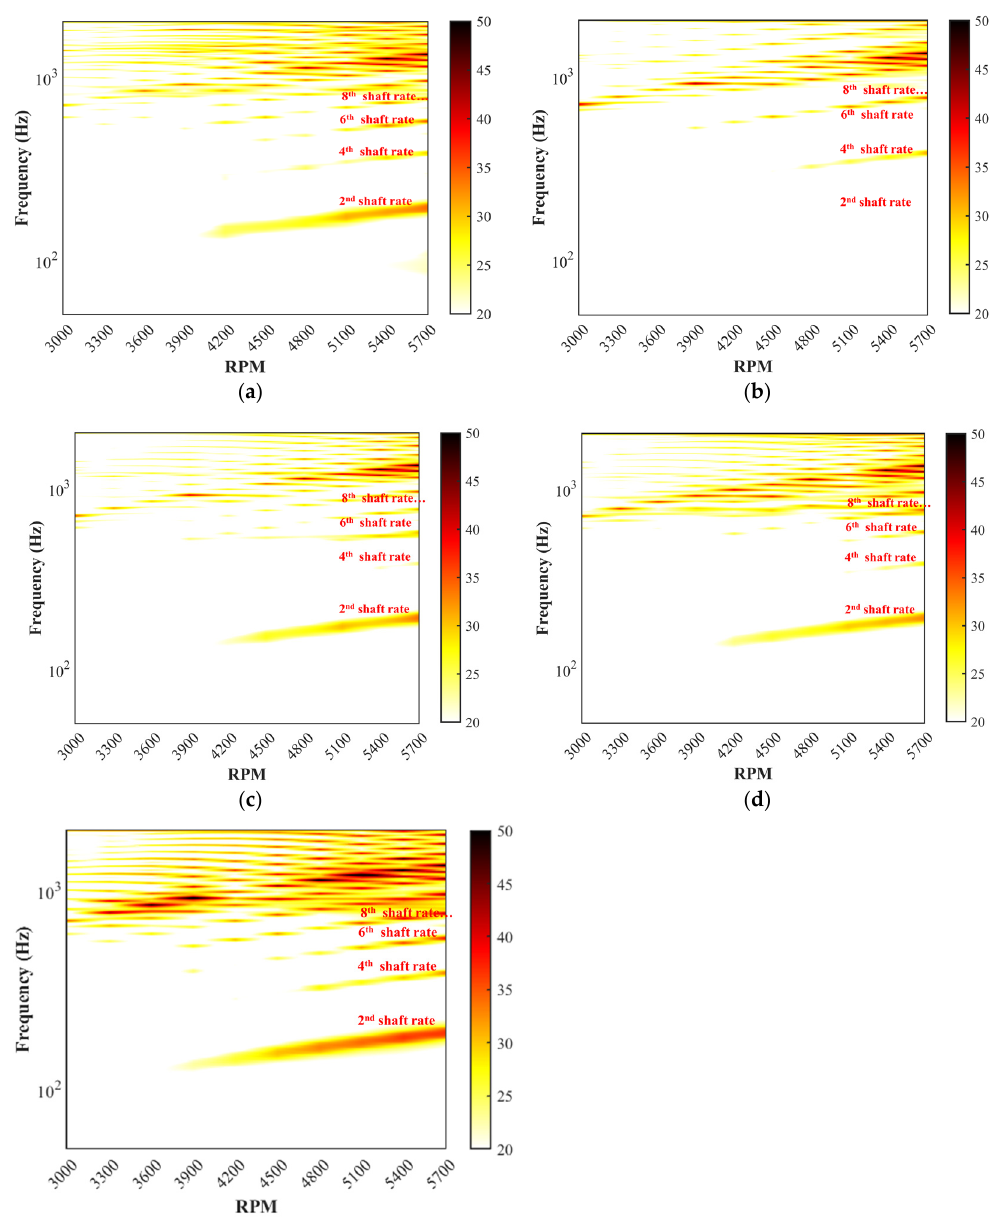
Figure 9. Contour maps of the SPL in dB ( Mic 2, θ = 25 deg) over a frequency range of 50–2000 Hz associated with propeller noises: ( a ) two-blade propeller (#1), ( b ) four-blade propeller (#2), ( c ) loop- type propeller (#3), ( d ) wide chord loop-type propeller (#4), and ( e ) DJI Phantom propeller (#5) at various rotational speeds.